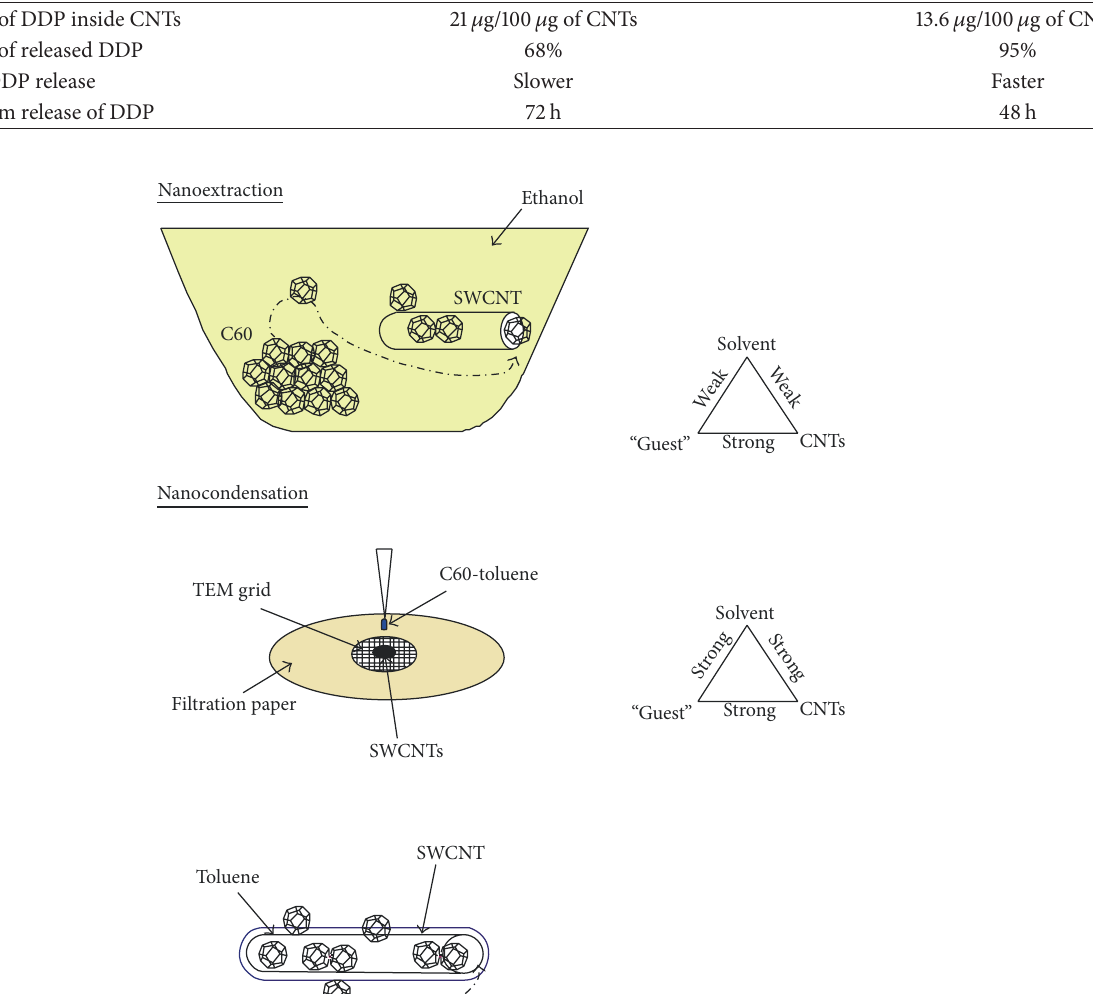
process used to the loading of cisplatin inside the